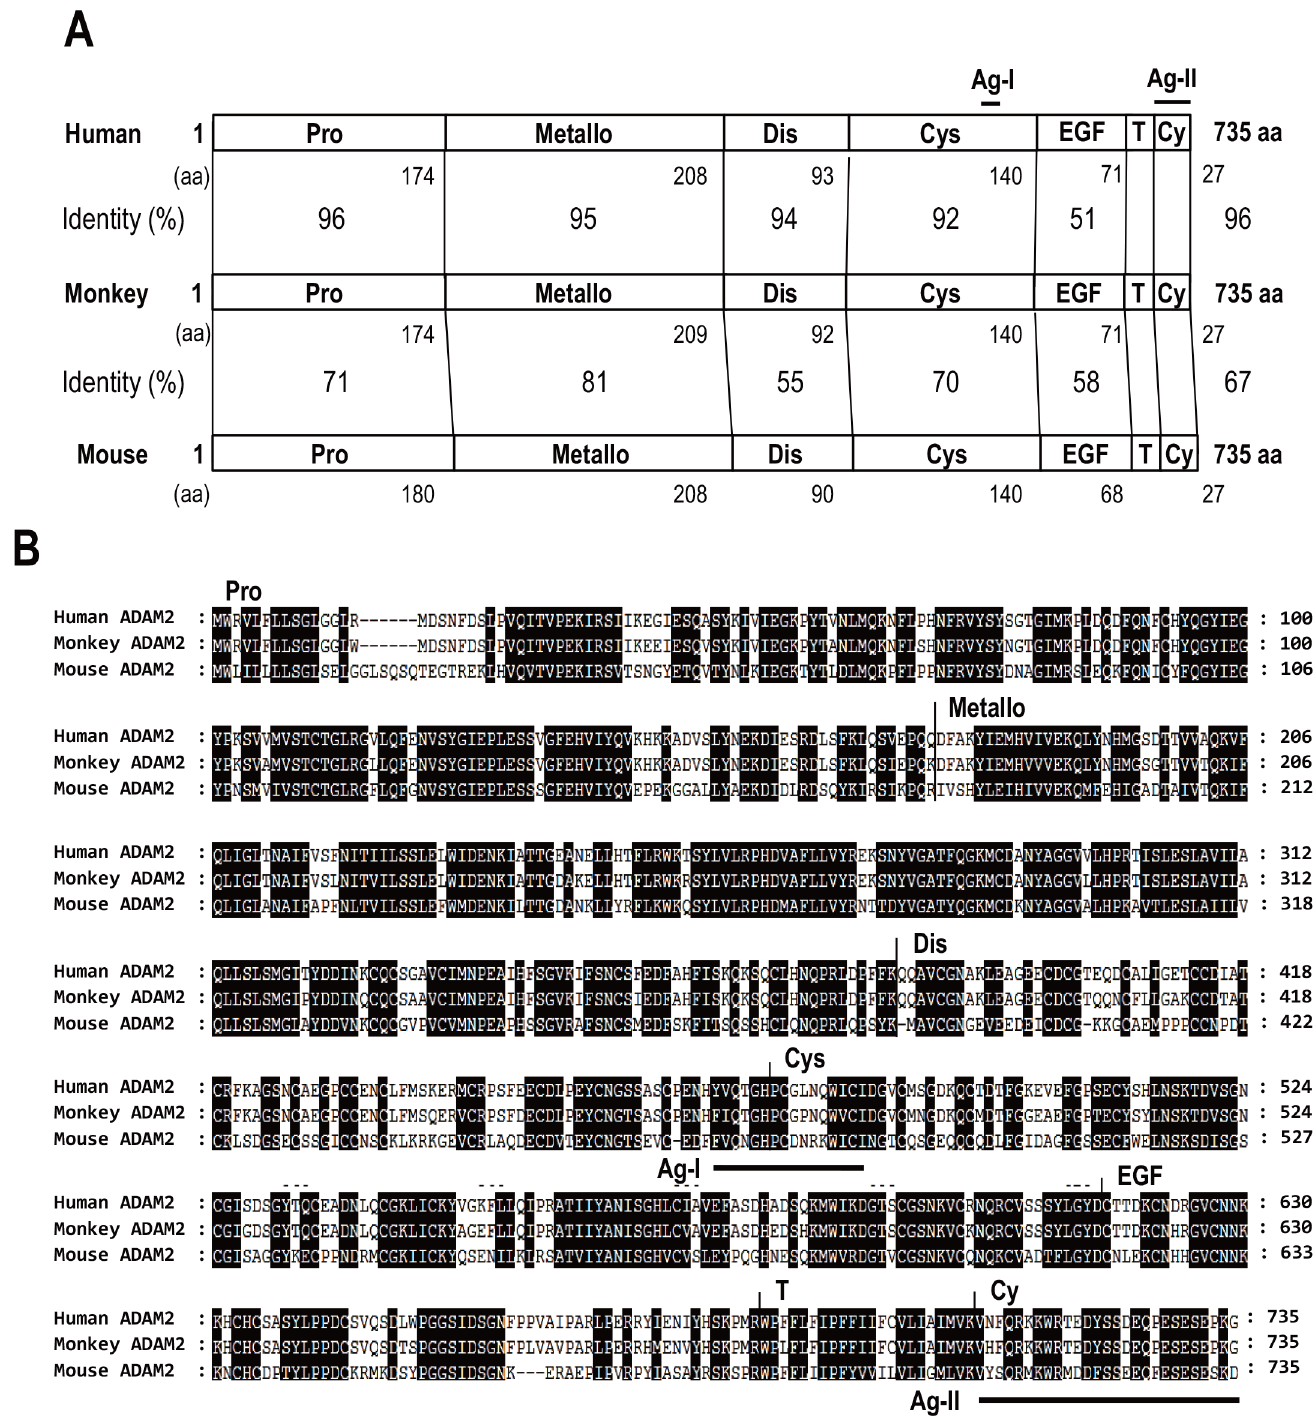
Fig 3. Amino acid sequence comparison of the mouse, monkey and human ADAM2 proteins. A . amino acid sequence identities are given as human versus mouse and monkey. B . Comparison of amino acid sequences of mammalian ADAM2. The consensus residues are shaded. Abbreviations: Pro, prodomain; Metallo, metalloprotease domain; Dis, disintegrin domain; Cys, cysteine-rich domain; EGF, epidermal growth factor (EFG)-like domain; T, transmembrane domain; Cy, cytoplasmic tail domain; Ag-1, antigen region of the anti-hADAM2-Cys antibody; and Ag-II, antigen region of the anti-hADAM2-CyT antibody.